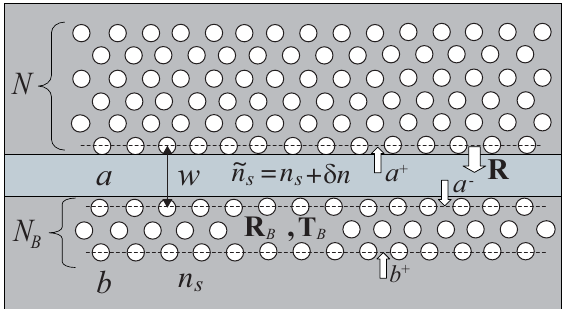
Figure 2. A single PhC waveguide with a guiding region ( a ) having a refractive index ˜ n s = n s + δ n , while the refractive index of the other regions is the same as in Figure 1, i.e., it is equal to n s . Reprinted from Ref.